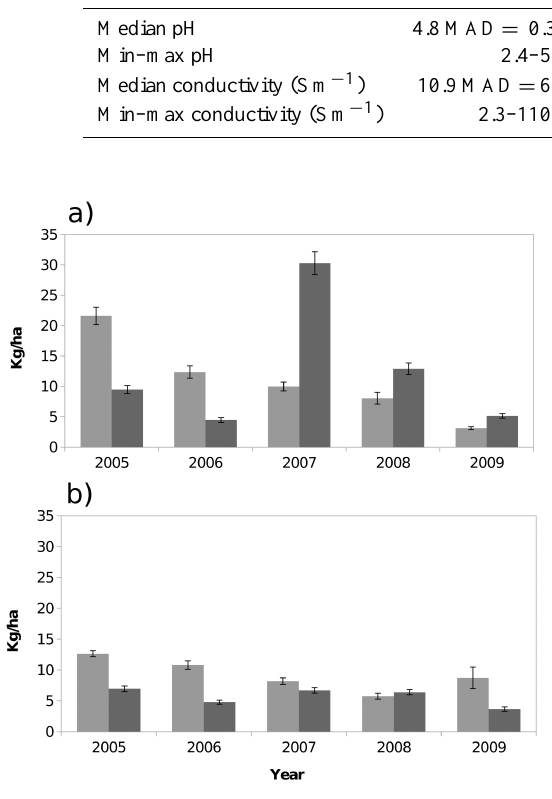
) deposition at (a) Cerro del Figure 3. Total yearly sulfate (SO − 4 Consuelo and (b) El Tiro meteorological stations (MSs). Dark grey bars represent deposition by rain and light grey bars, deposition by occult precipitation